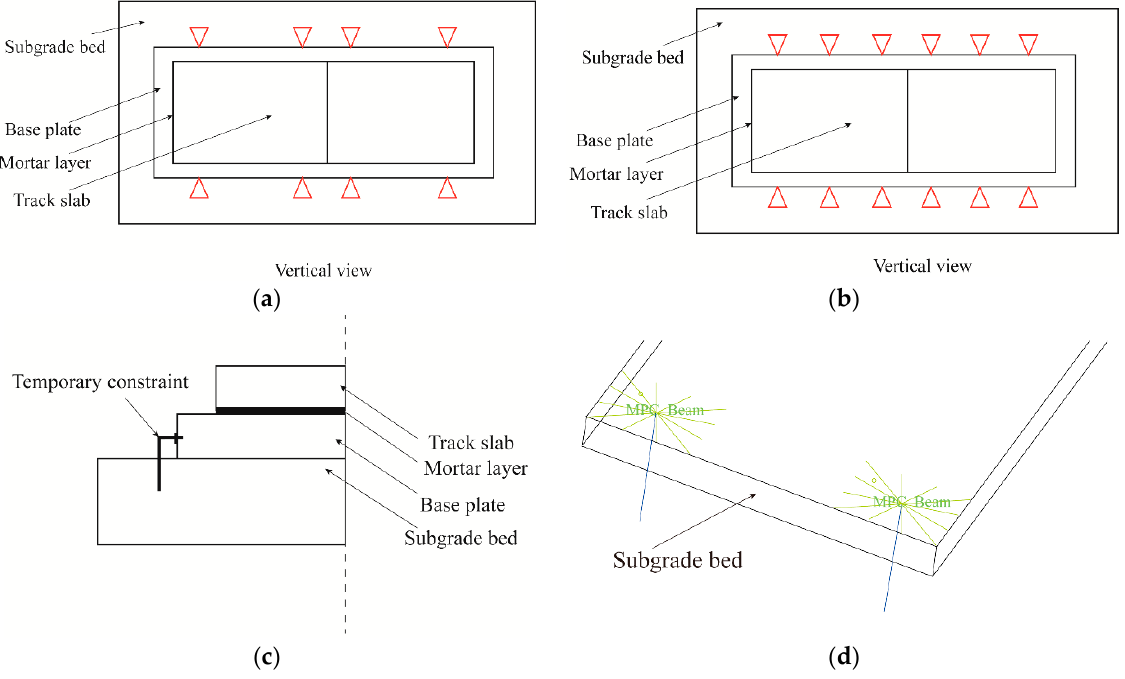
Figure 19. Two schemas of temporary constrain. ( a ) top view of temporary constraint 1, ( b ) top view of temporary constraint 2, ( c ) lateral view of temporary restraint, ( d ) schematic diagram of connection mode of "Beam MPC" in ABAQUS.